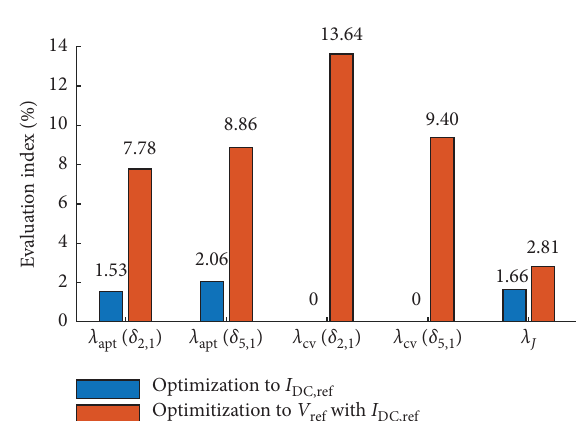
Figure 10: Comparison of optimization to I to V ref with I DC,ref